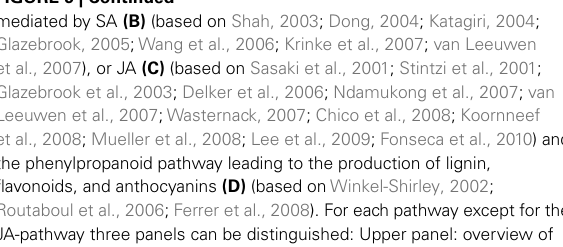
modulated gene expression during ISR-prime in plants 2days post-inoculation with T. hamatum T382 vs. mock-treated control plants. Middle panel: overview of modulated gene expression during BIDR in plants 2days post-inoculation with B. cinerea vs. mock-treated control plants. Lower panel: overview of modulated gene expression during ISR-boost in plants pretreated with T. hamatum T382 vs. mock-treated control plants, both 2days post-inoculation with B. cinerea . For the JA-pathway five panels can be distinguished because both 1 and 2days post-inoculation with B. cinerea are shown for ISR-boost and BIDR. Up- and downregulated genes are shown in red and green respectively. Gene names are in conformity withTAIR